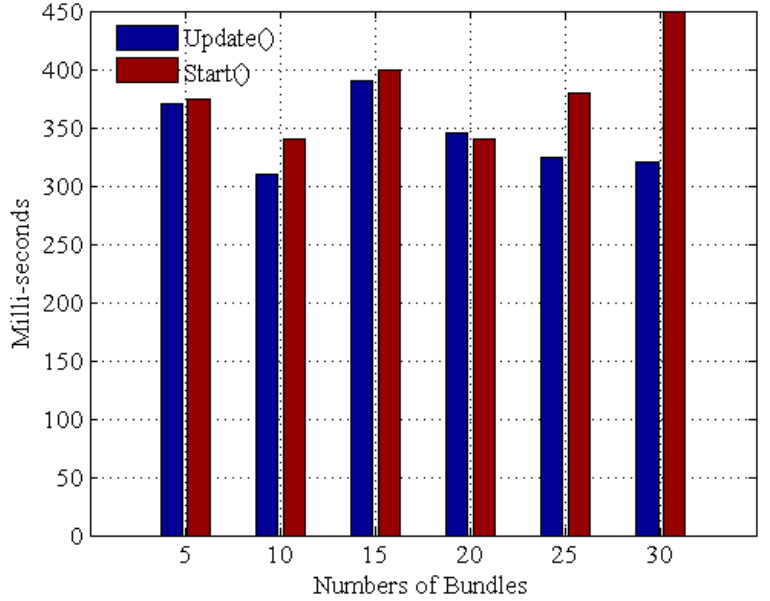
Figure 15. Execution times with bundles variation.